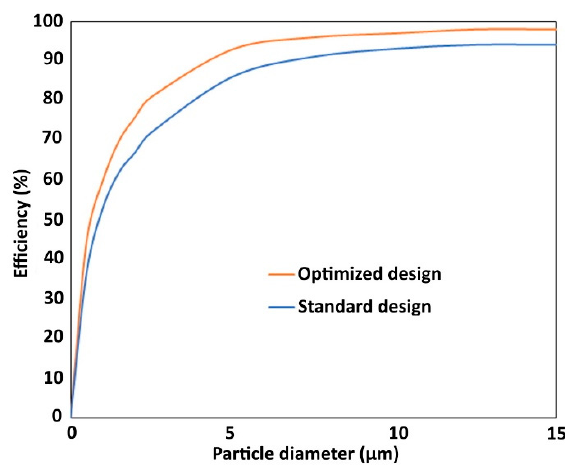
Figure 5. Cyclone efficiency curves, standard and optimized design [13].